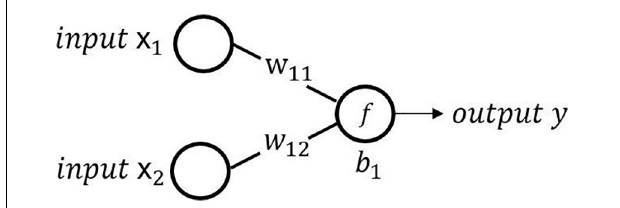
FIGURE 3 | Schematic diagram of neural network